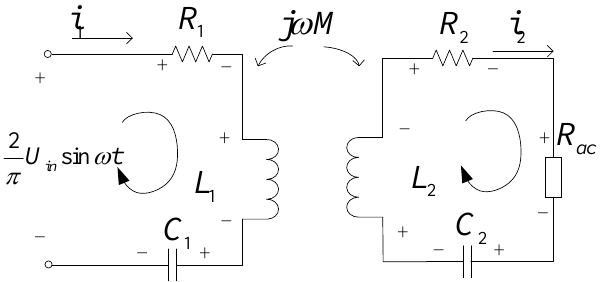
Figure 5. Equivalent circuit of SHRC IPT system using harmonic approximation method.